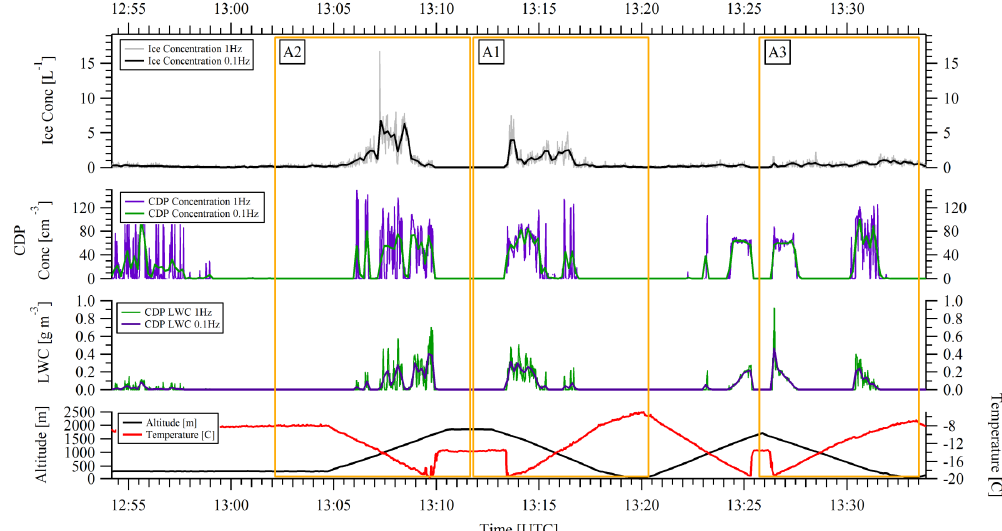
Figure 2. Microphysics time series for spring case 1. Data includes temperature ( ◦ C) and altitude (m) (lower panel) together with 1 and 10s data sets for CDP liquid water content (gm − 3 ) (panel 2 from bottom), CDP cloud particle number concentration (cm − 3 ) (panel 3) and ice water content (gm − 3 ) and ice number concentrations (L − 1 ) (top panel). Profiles A2 and A3 are described in the